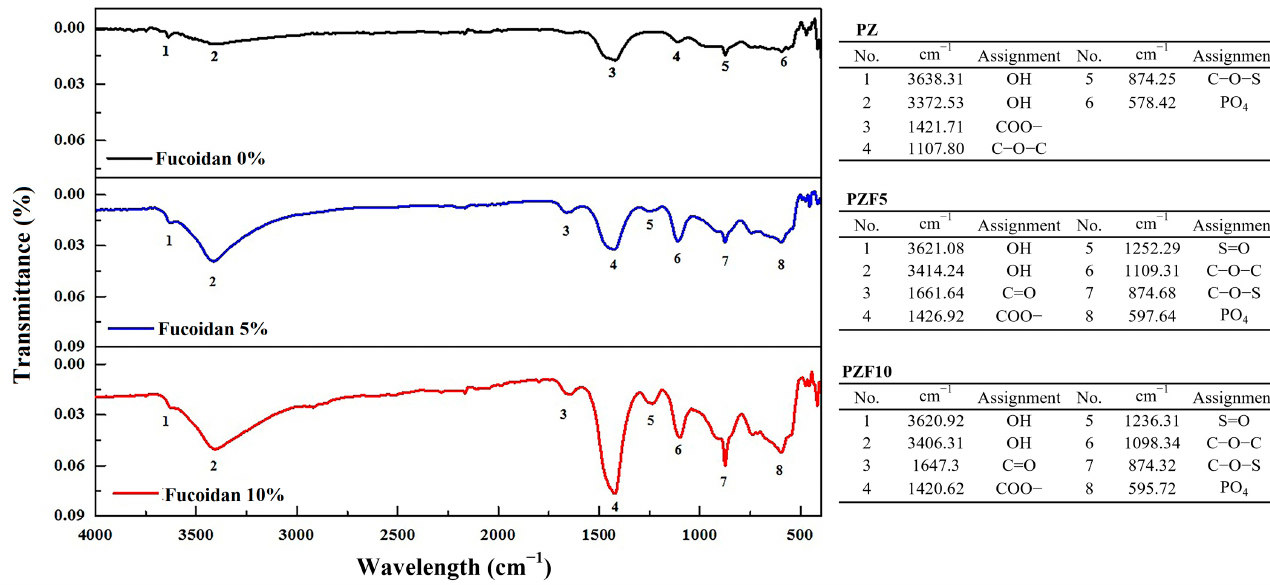
Figure 3. Fourier-transformed infrared spectroscopy results of PZ, PZF5, and PZF10. The functional groups in relation to the specific peaks are described in the text.